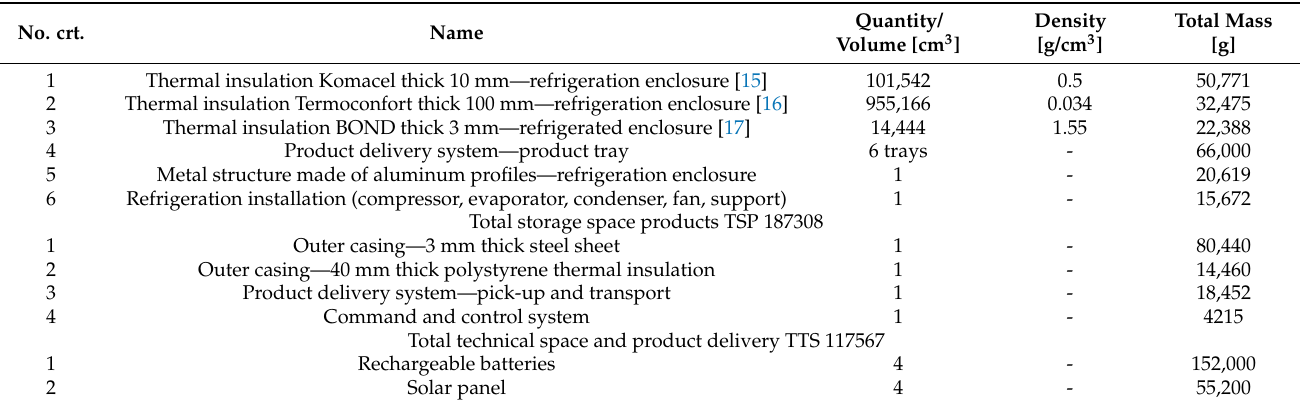
Table 1. Resistance structure